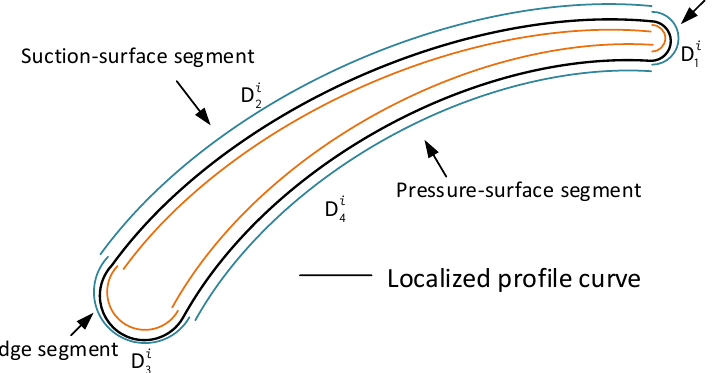
Figure 3. The profile curves of the to-be-cut blade surface need to be within the tolerance band. The to-be-cut material on the blade billet is more uniform, and the cutting status is more stable. Therefore, the objective of the proposed localization is to make the material allowance more uniform. To obtain a favorable to-be-cut blade surface, we establish a flexible localization implemented by a multi-constraint optimization. Optimization variable: the translation and the rotation matrices of the profile curves on the designed blade sections. The translation matrix is denoted as T , and the rotation matrix is denoted as R . Each profile curve is localized by its translation matrix and realized by the rotation matrix. The to-be-cut blade surface is reconstructed by the lofting method in terms of the respective profile curves that were localized. Optimization Objective : The objective of the uniform to-be-cut material is substi- tuted by the distance between the measured points of the blade billet and the to-be-cut blade surface. It is represented by